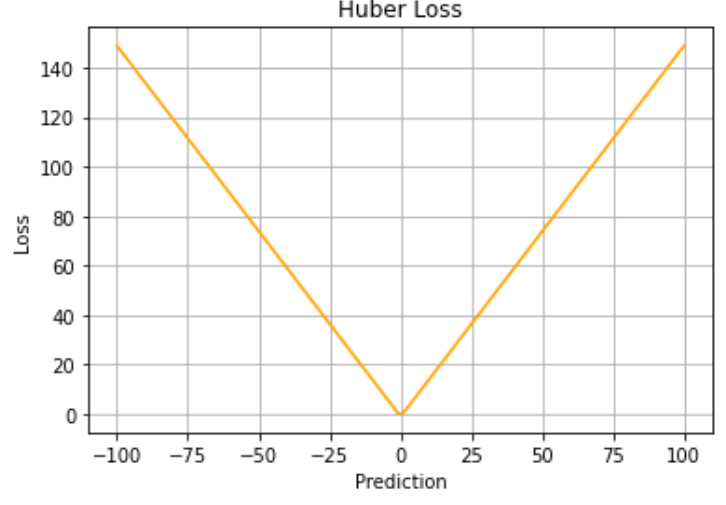
Figure 5. Huber loss.